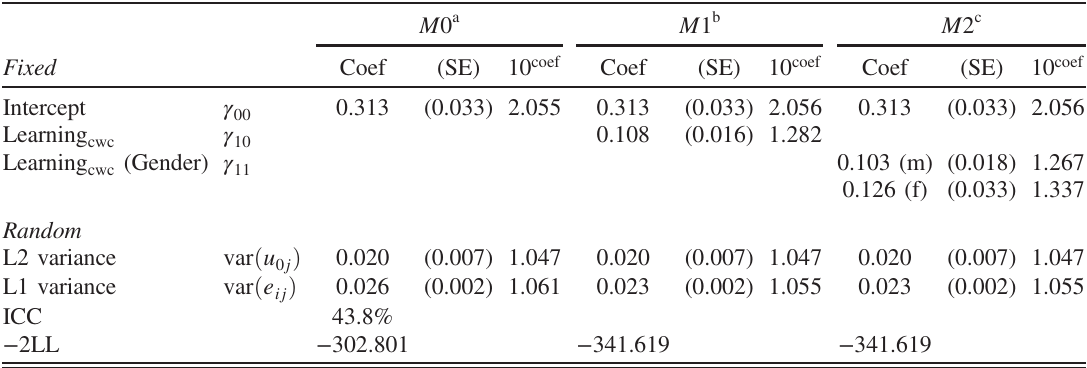
TABLE IV. LOG10 values of accelerants as the outcome for three different models. The values are all statistically significant ( p < 0 . 05 ), the significance of slope variance was tested with chi-square test using − 2